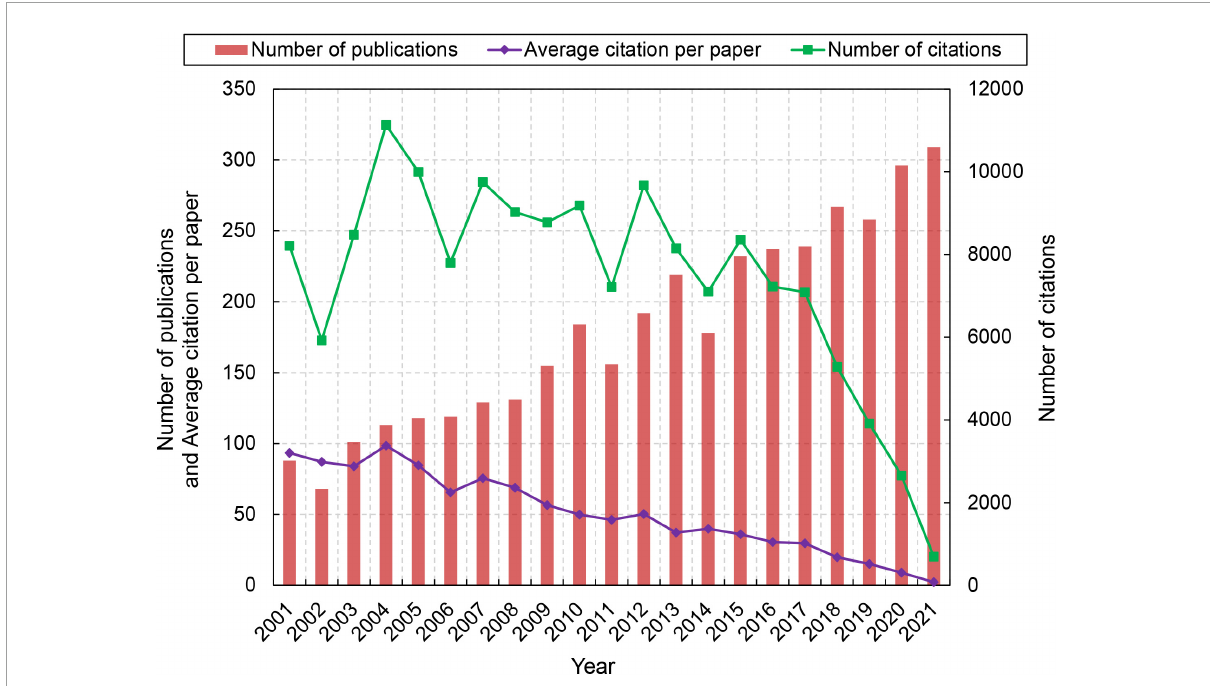
FIGURE1 Trend in the number of publications in the field of stroke and astrocyte during the period 2001–2021.